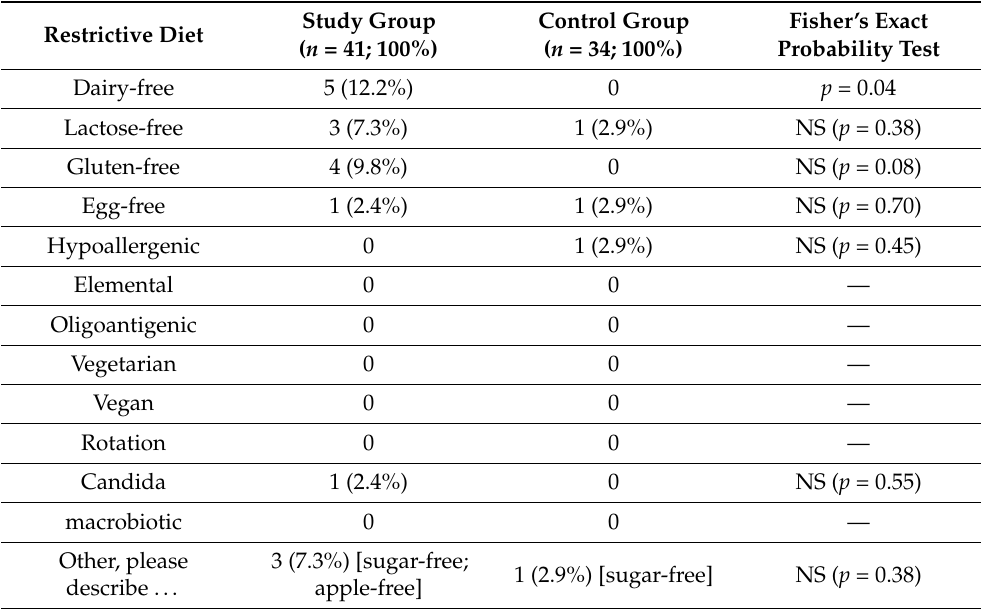
Table 12. Types of restrictive diets used by the children in the Study Group and the Control Group (question II/20).